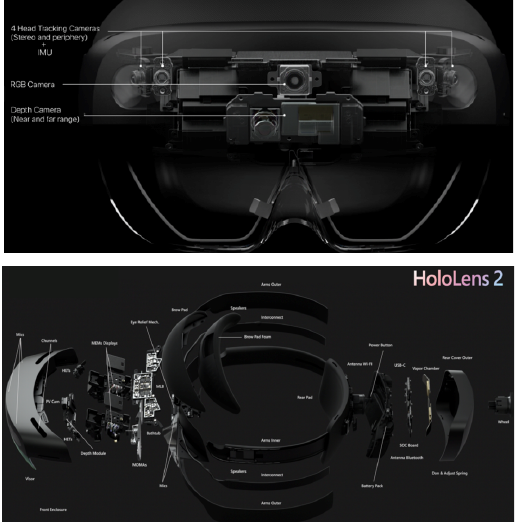
Figure 3. The HHMD HoloLens 2 device with its various components (Microsoft,